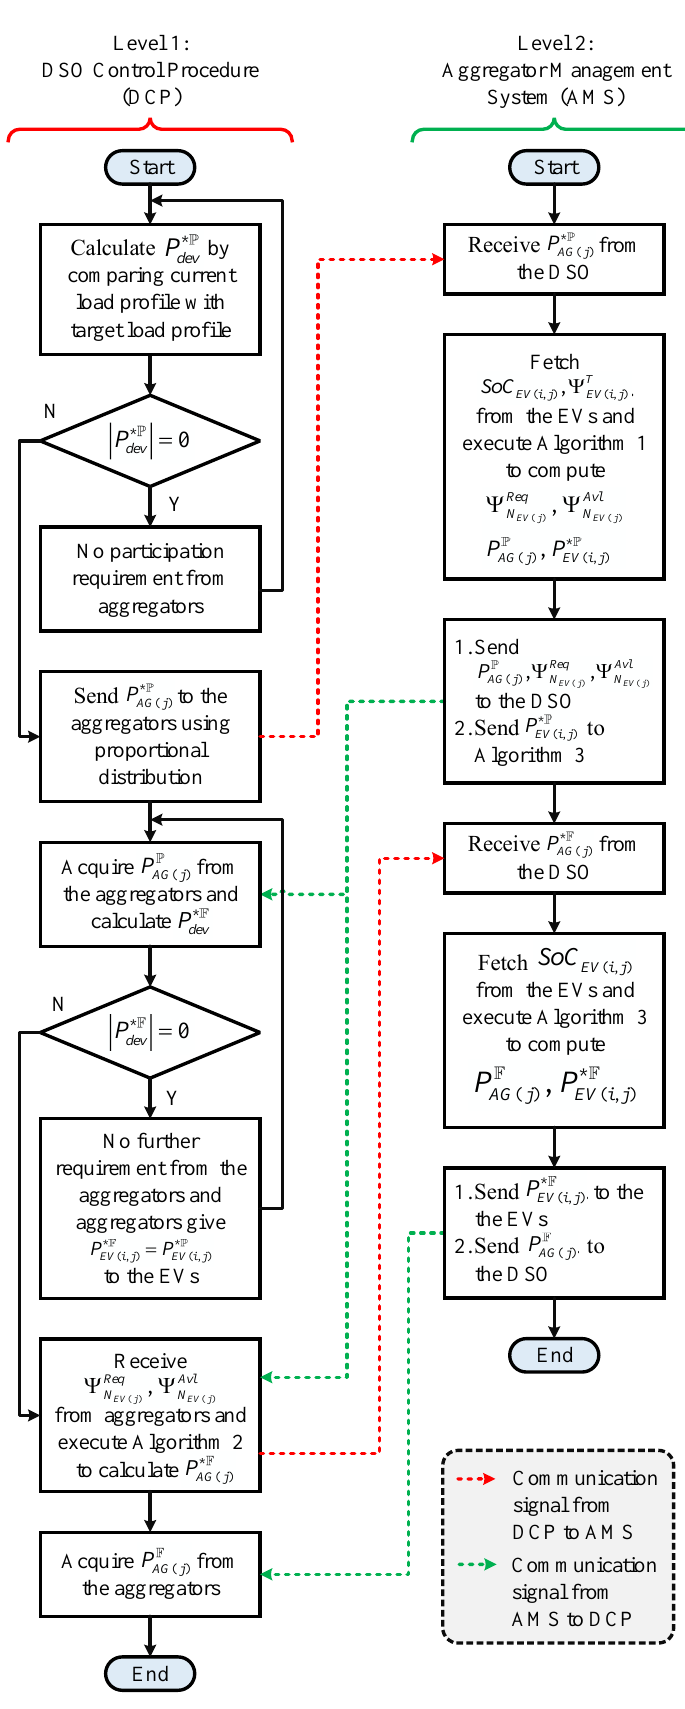
Figure 3. Bi-level coordination scheme control